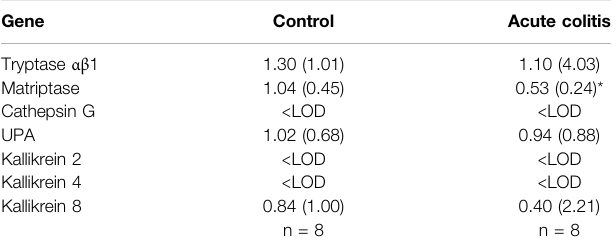
TABLE 4 | Relative mRNA expression of serine proteases in colon samples in acute TNBS colitis